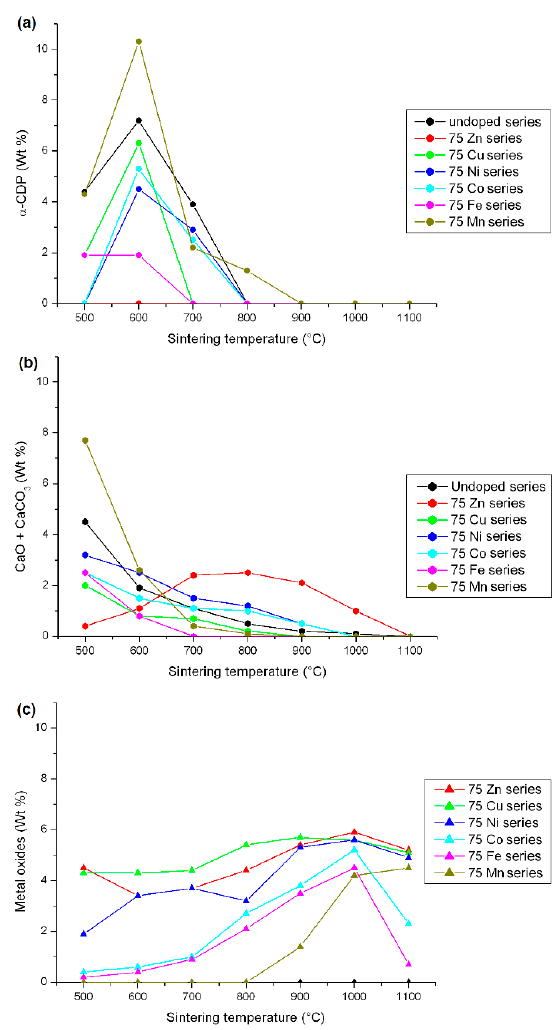
Figure 2. Weight percent of minor phases (( a ) α -CDP; ( b ) sum of CaCO 3 and CaO; ( c ) metal oxides) for the 75 M -T samples: red lines for the 75Zn-T series with ZnO as metal oxide, green lines for the 75Cu-T series with CuO as metal oxide, dark blue lines for the 75Ni-T series with NiO as metal oxide, light blue lines for the 75Co-T series with Co 3 O 4 and CoO as metal oxide, pink lines for the 75Fe-T series with Fe 2 O 3 as metal oxide, and dark green lines for the 75Mn-T series with the sum of Mn 3 O 4 and CaMn 2 O 4 as metal oxide. The lines are only visual guides.